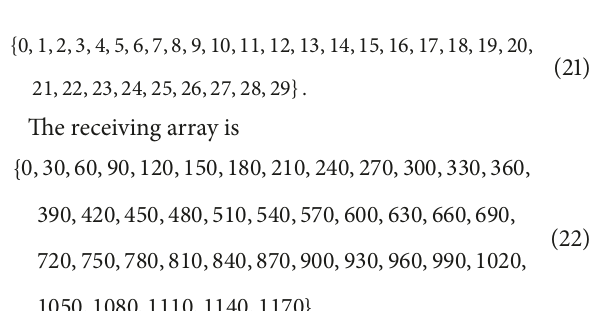
Figure 17: Difference